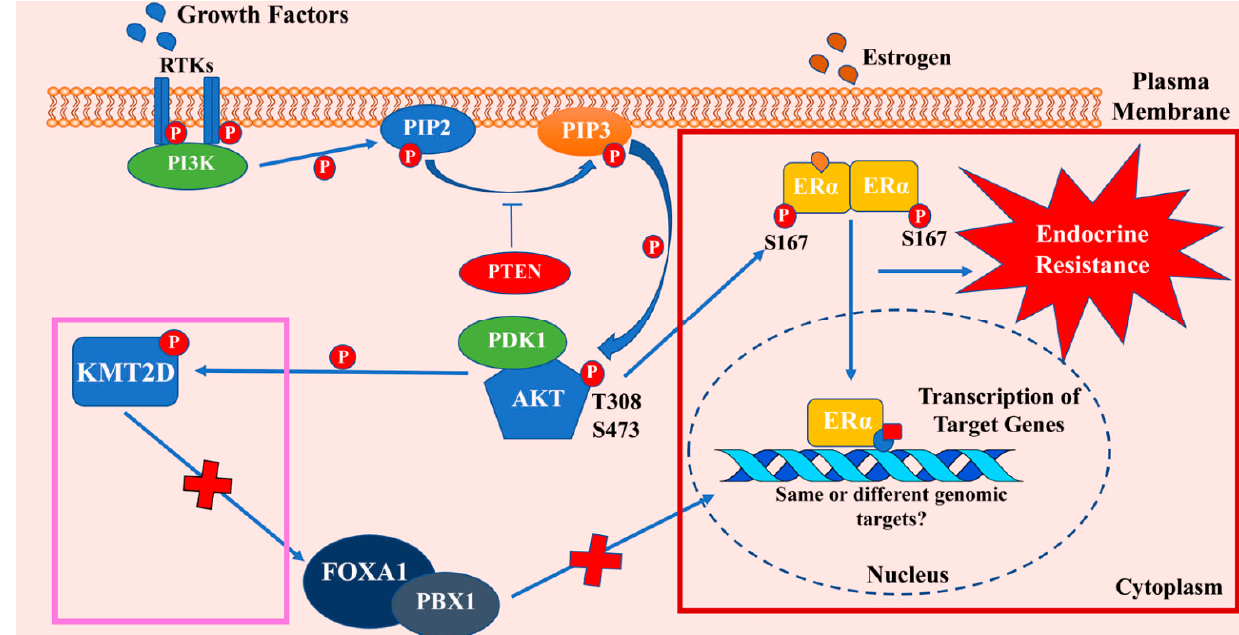
Figure 3. Nexus between PI3K/AKT and ER α pathways. Nexus between these two pathways involves both positive (red rectangle) and negative (pink rectangle) loops. Activation of PI3K leads to activation of AKT, which can directly phosphorylate ER α to promote ligand-independent activity and endocrine therapy resistance. However, AKT-mediated phosphorylation triggers degradation of the histone methyltransferase KMT2D, which is required for opening the chromatin region for binding of pioneer factors FOXA1 and PBX1. FOXA1 and PBX1 facilitate ER α binding to the genome. It is unknown whether genome wide binding and gene expression changes by ER α phosphorylated by AKT and that facilitated by KMT2D are different and contribute differentially to antiestrogen response.